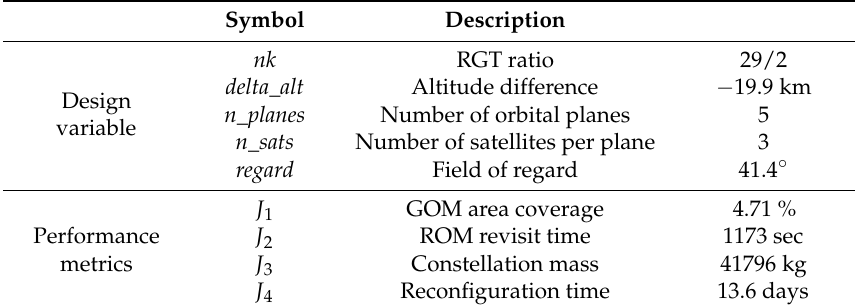
Table 21. Sun-synchronous orbits (SSO) ReCon optimization